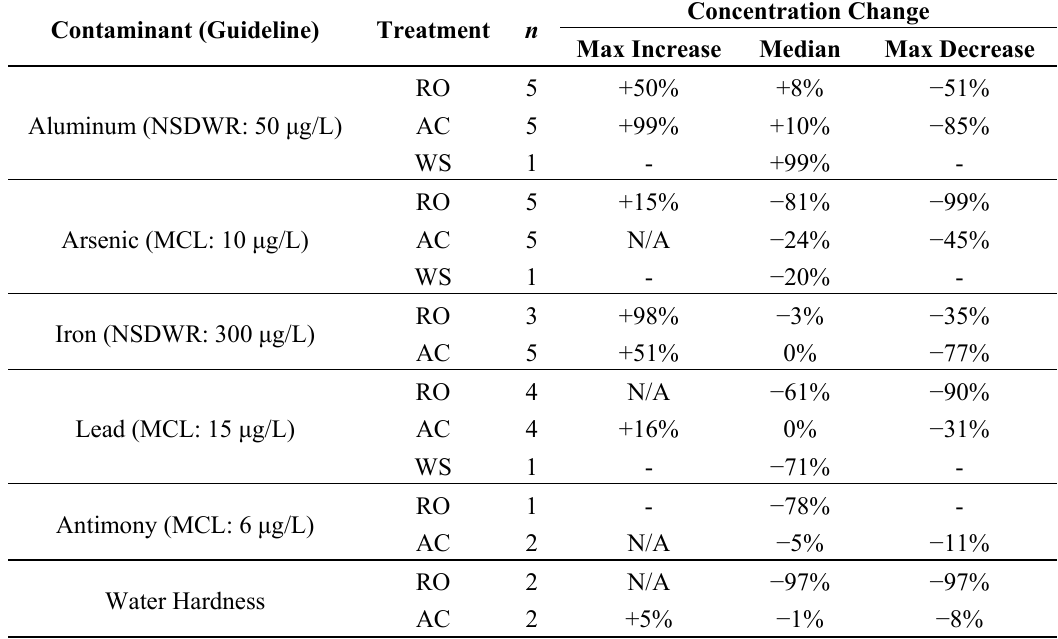
Table 5. Percent concentration change for contaminants with concentrations exceeding either MCL or NSDWR guidelines and for water hardness by treatment type (RO: reverse osmosis; AC: activated carbon; WS: water softener). Decreases of